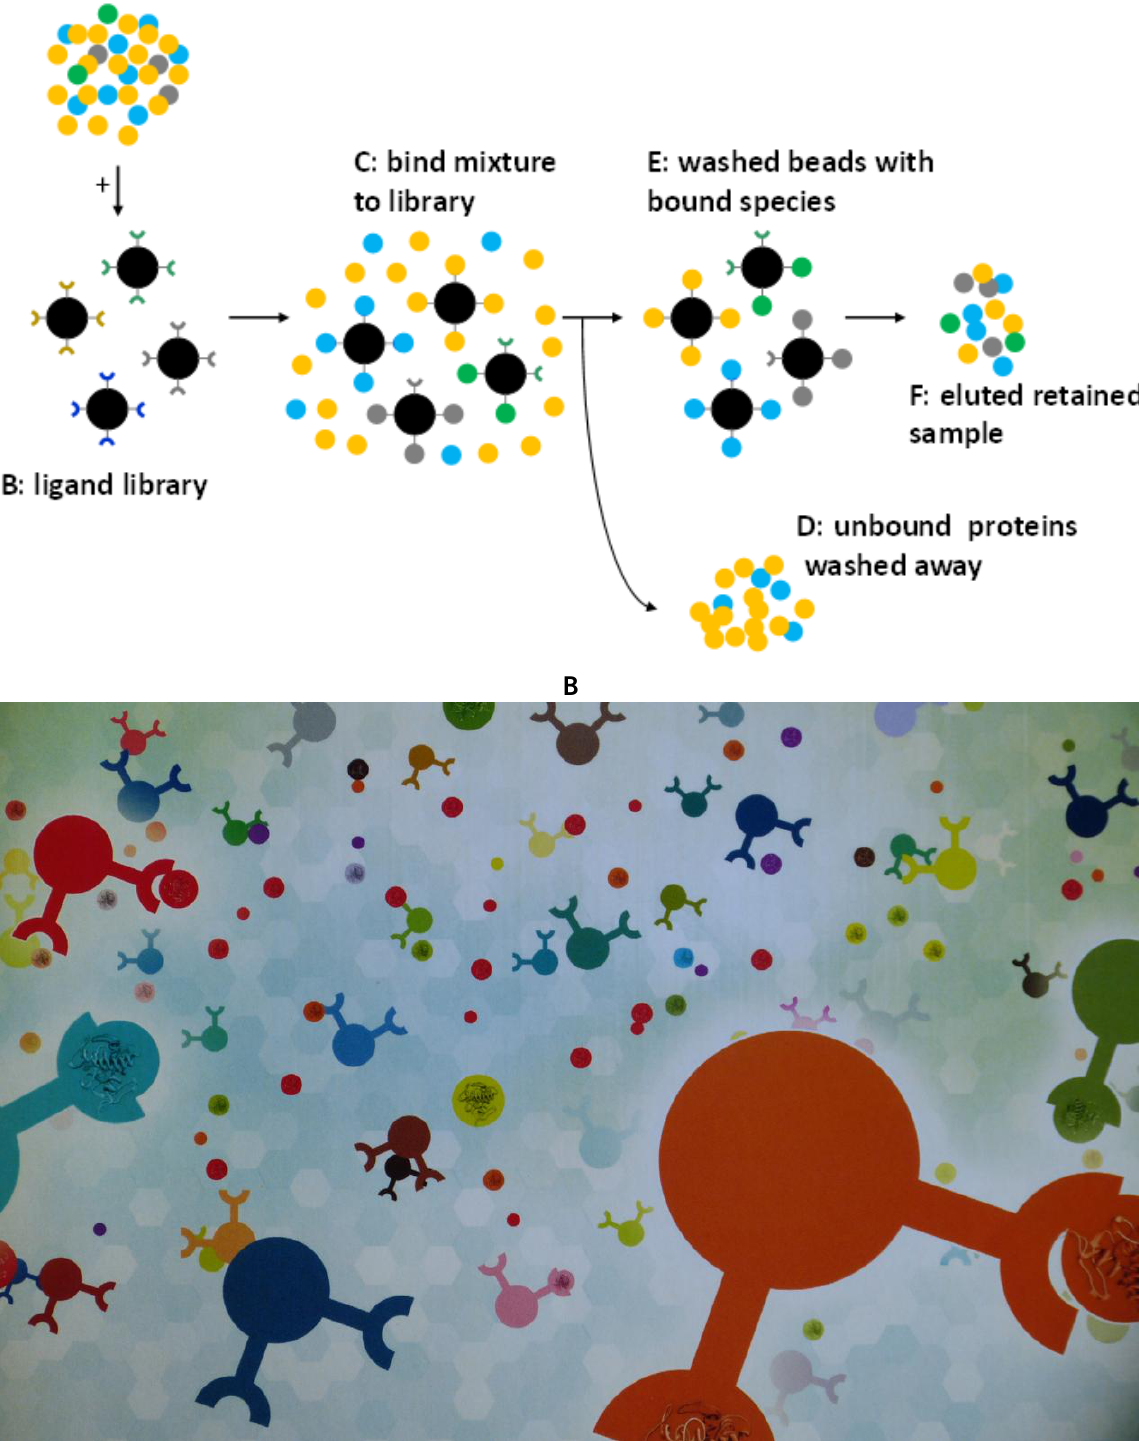
Figure 1. ( A ) Mechanism of action of combinatorial peptide ligand libraries. ( B ) Artistic rendering of combinatorial peptide ligand library (CPLL) beads with proteins docked on the hexapeptide